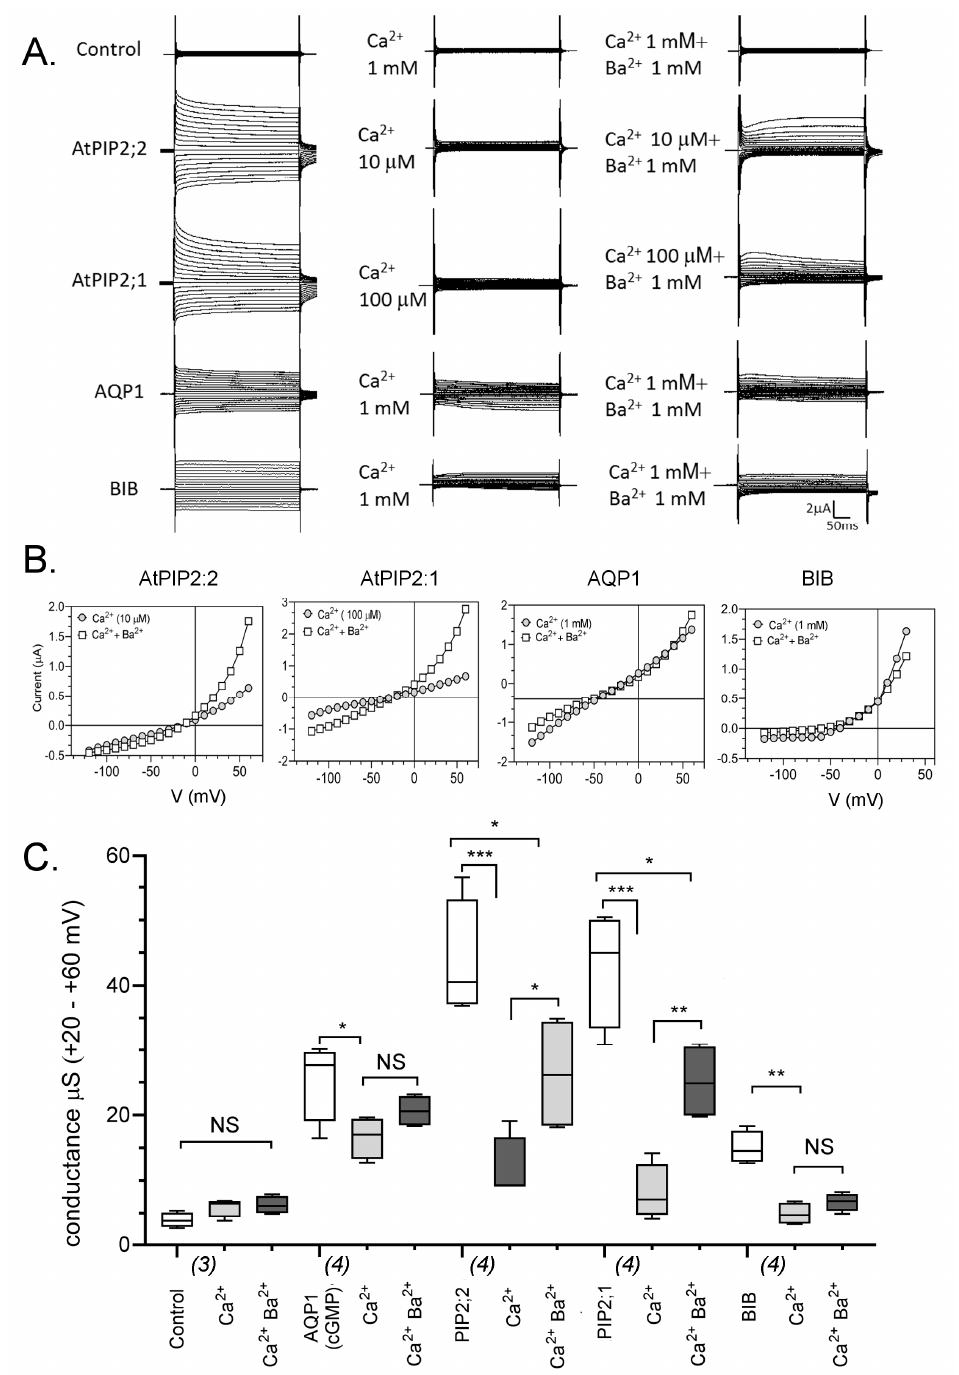
Figure 5. Effects of sequential application of Ca 2+ followed by Ba 2+ on ionic current responses in oocytes expressing different classes of AQPs. ( A ) Superimposed current traces under voltage clamp showing the maximal responses of AtPIP2;2, AtPIP2;1, HsAQP1 and DmBIB expressing oocytes recorded in divalent-free saline ( left ), after perfusion of saline containing the indicated amount of free Ca 2+ ( middle ), and after application of Ba 2+ in the continuing presence of the same concentration of Ca 2+ ( right ). ( B ) Current-voltage relationships for traces shown in ( A ). ( C ) Summary box plot of conductance values for AtPIP2;2, AtPIP2;1, HsAQP1 and DmBIB expressing oocytes in different divalent cation salines. *** ( p < 0.001); ** ( p < 0.01); * ( p < 0.05); NS (not significant); using ANOVA with post hoc Bonferroni tests; n values are below the x -axis.